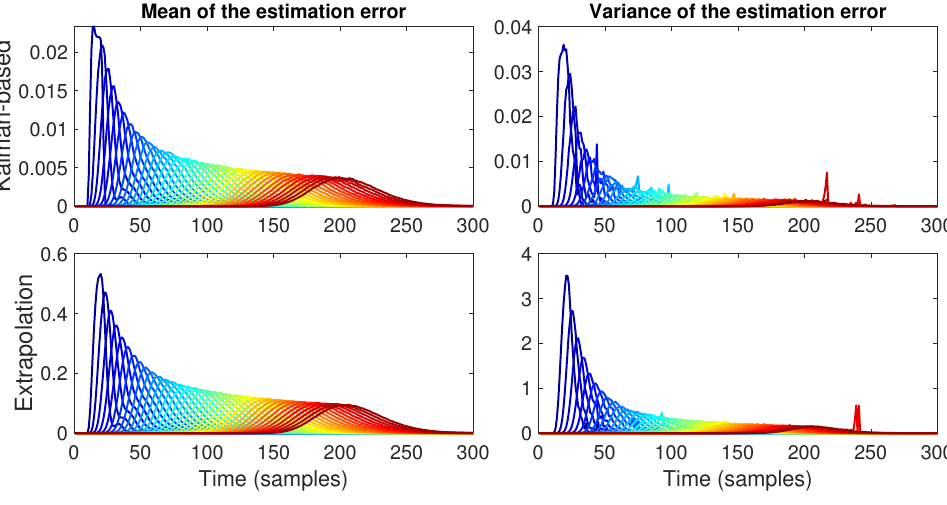
( k ) and variance σ 2 ( k ) of the estimation error for p = 0.75. Here, the peak mean Figure 16. Mean µ ε ε i i and variance also increase to values of 0.02 and 0.03, respectively, whereas the extrapolation mean and variance increase to values of 0.5 and around 3.5,